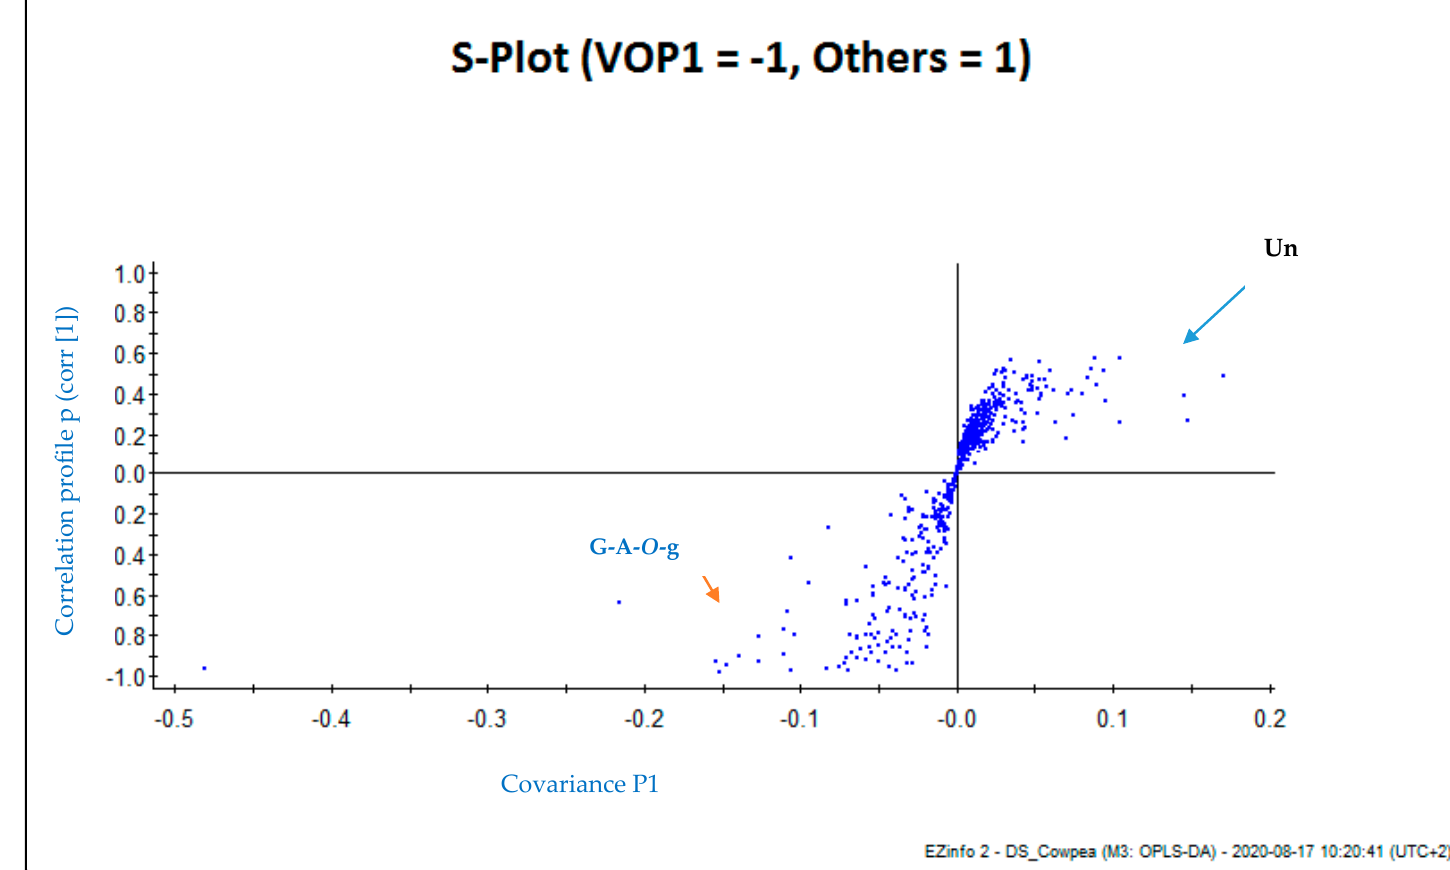
Figure 3. Score plot of orthogonal partial least squares discriminant analysis of UPLC–Q-TOF/MS spectra of the leaves of different cowpea cultivars. Gentisic acid 5- O -glucoside (G-A- O -g), Un — Unidentified compound.